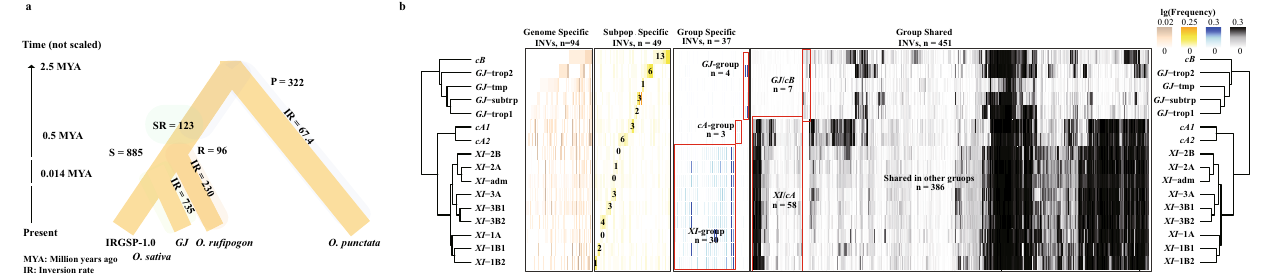
Fig. 4 | Species-speci fi c, population-speci fi c and shared inversion analysis of the pan-genome inversion index of rice. a A model showing species speci fi c inversions and inversion rates in Asian rice and two wild relatives ( O.punctata and